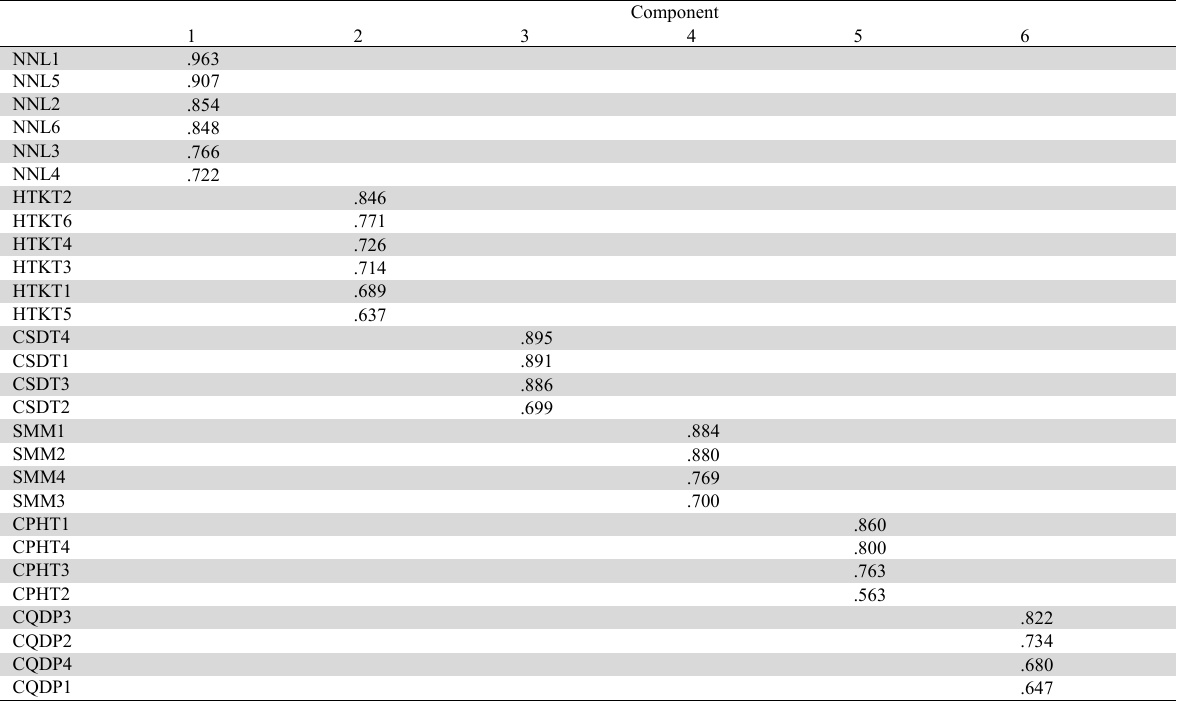
Rotated component matrix